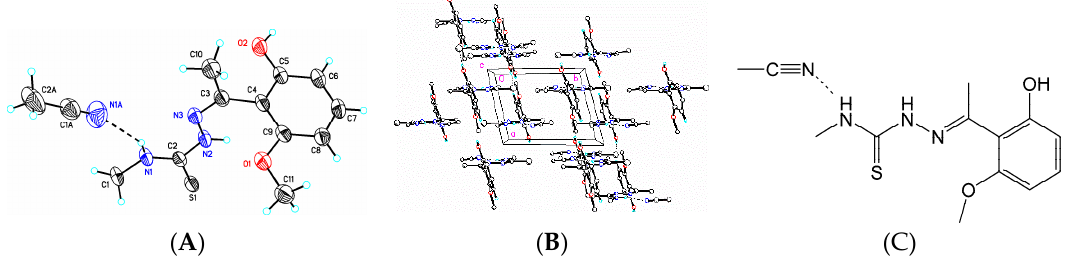
Figure 5. ( A ) ORTEP drawing of ( 5 ) showing the atom numbering scheme and 50% probability displacement ellipsoids of non-H atoms; ( B, C ) The molecular packing for ( 5 ) viewed along the b axis. Dashed lines indicate N–H … N intramolecular hydrogen bonds and weak O–H … S intermolecular interactions. Hydrogen atoms not involved in hydrogen bonding have been removed for